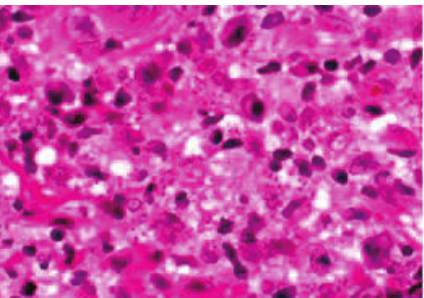
Figure 4: Histology of the oral lesion showing macrophages containing numerous Leishman